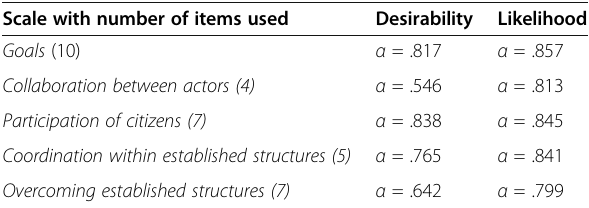
Table 1 Scales with their number of items and internal consistency based on Cronbach ’ s alpha